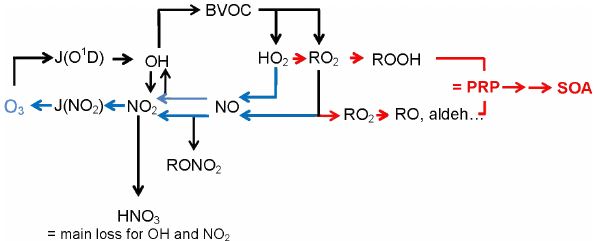
Fig. 1. Schematics of the basic reactions leading to SOA forma- tion, considered in this study. BVOC oxidation forms peroxy radi- cals that, depending on the NO concentrations, have different fates. At low NO x conditions, permutation reactions among RO 2 (includ- ing HO 2 ) are predominant (red arrows). Products of permutation reactions are termed PRP. At high NO x conditions, peroxy radicals react predominantly with NO. Products of RO 2 + NO reactions are NO 2 and organic nitrates. NO 2 is photolyzed and subsequently O 3 is formed. On photolysis in the ultraviolet, O 3 is precursor of OH. Main sink of OH, the oxidant driving this chemistry, is the OH + NO 2 reaction. This reaction is also the main sink of NO 2 in the